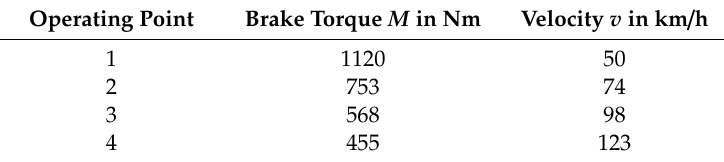
Figure 3. Design of experiment for reproducibility investigation of PM 10 temperature dependency. Table 1. Pressure-velocity-operating points used for the advanced temperature triangle test.